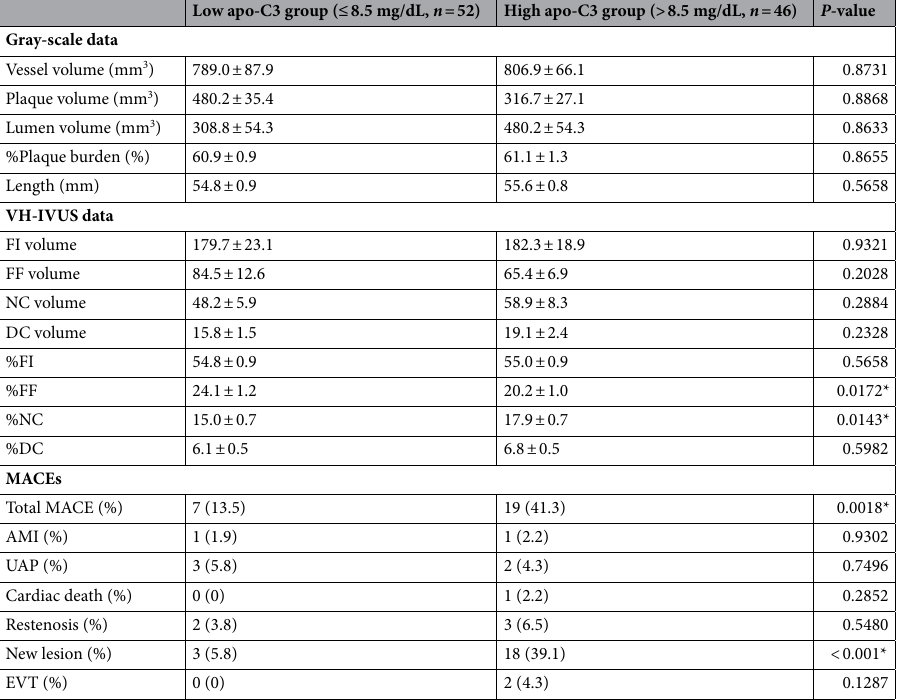
Table 3. Comparisons of grayscale IVUS, VH-IVUS data, and MACEs between the low and high apo-C3 groups. Values are presented as mean ± standard errors or as numbers (percentages) of patients. * P < 0.05. apo- C3 Apolipoprotein C3; IVUS Intravascular ultrasound; VH-IVUS Virtual histology-intravascular ultrasound; FI Fibrous; FF FIbrofatty; NC Necrotic core; DC Dense calcium; %FI Percentage of the FI volume in the plaque volume; %FF Percentage of the FF volume in the plaque volume; %NC Percentage of the NC volume in the plaque volume; %DC Percentage of the DC volume in the plaque volume; MACE Major cardiovascular event (defined in the manuscript); AMI Acute myocardial infarction; UAP Unstable angina pectoris; EVT Endovascular therapy; CI Cerebral